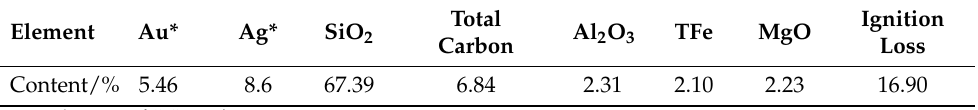
Table 1. Chemical composition analysis of raw ore.